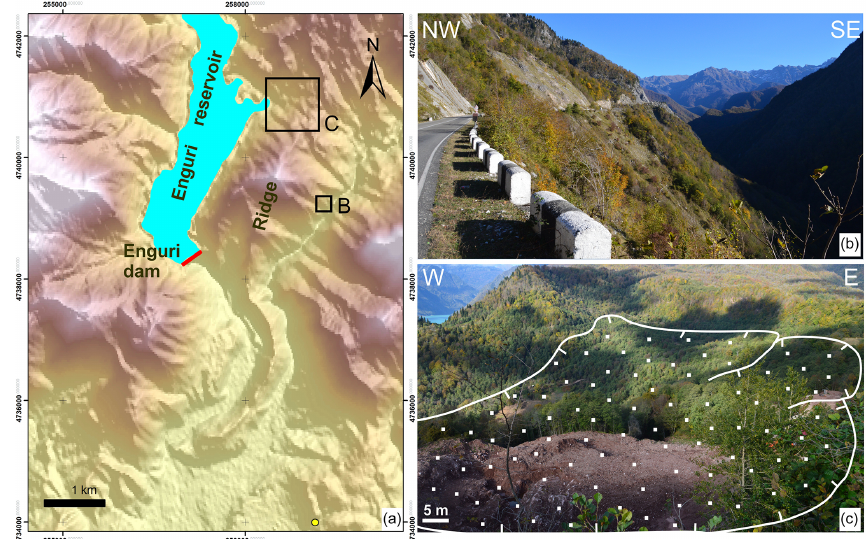
Figure 3. (a) DEM of the Enguri dam area. Boxes show the location of panels (b) and (c) . (b) Segment of the Jvari–Khaishi–Mestia road where it crosses the eastern slope of the ridge highlighted in (a) ; here rocks and slopes are very steep, up to 70 ◦ C. Oblique view (looking north) of the area, facing the Enguri water reservoir, affected by active slope deformation. The scale only refers to the forefront